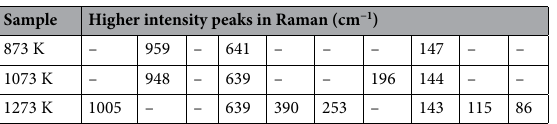
Table 5. Raman displacement of the highest intensity peaks for the calcined SiTiNb-B samples.